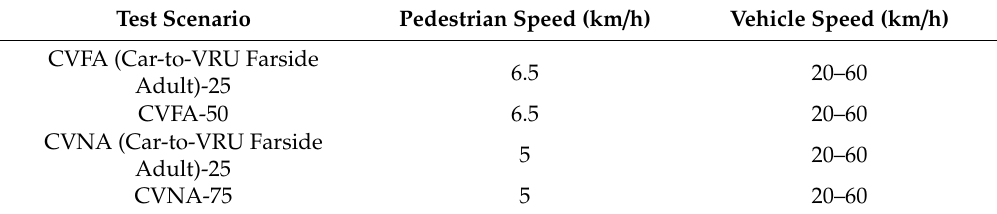
Table 9. Autonomous emergency braking pedestrian (AEB-P) system test